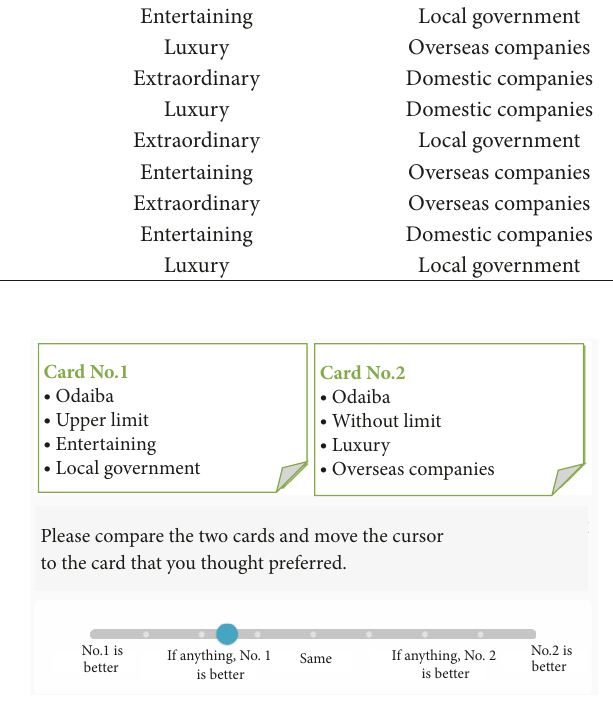
Figure 2: A sample questionnaire